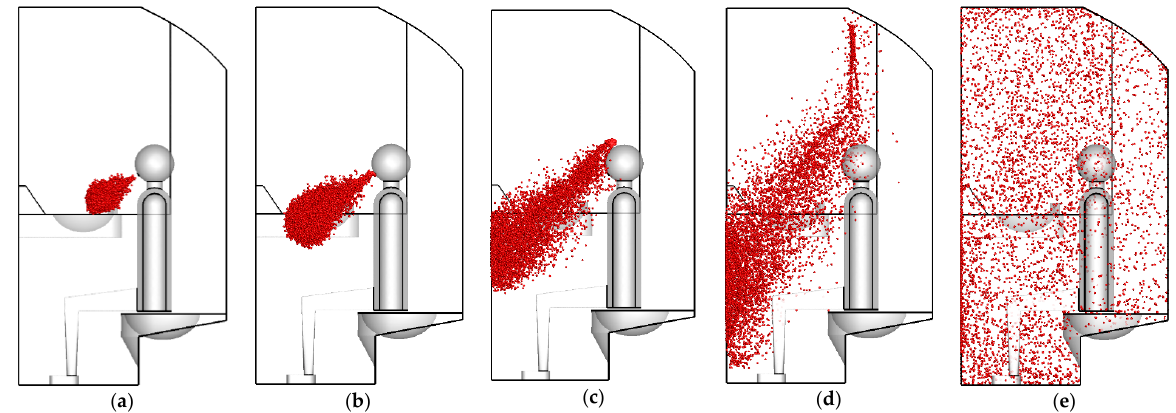
Figure 13. Time series of 1 µm bioaerosol distribution pattern for Case 3 at ( a ) 0.2 s; ( b ) 0.6 s; ( c ) 2 s; ( d ) 6 s; ( e ) 36 s.